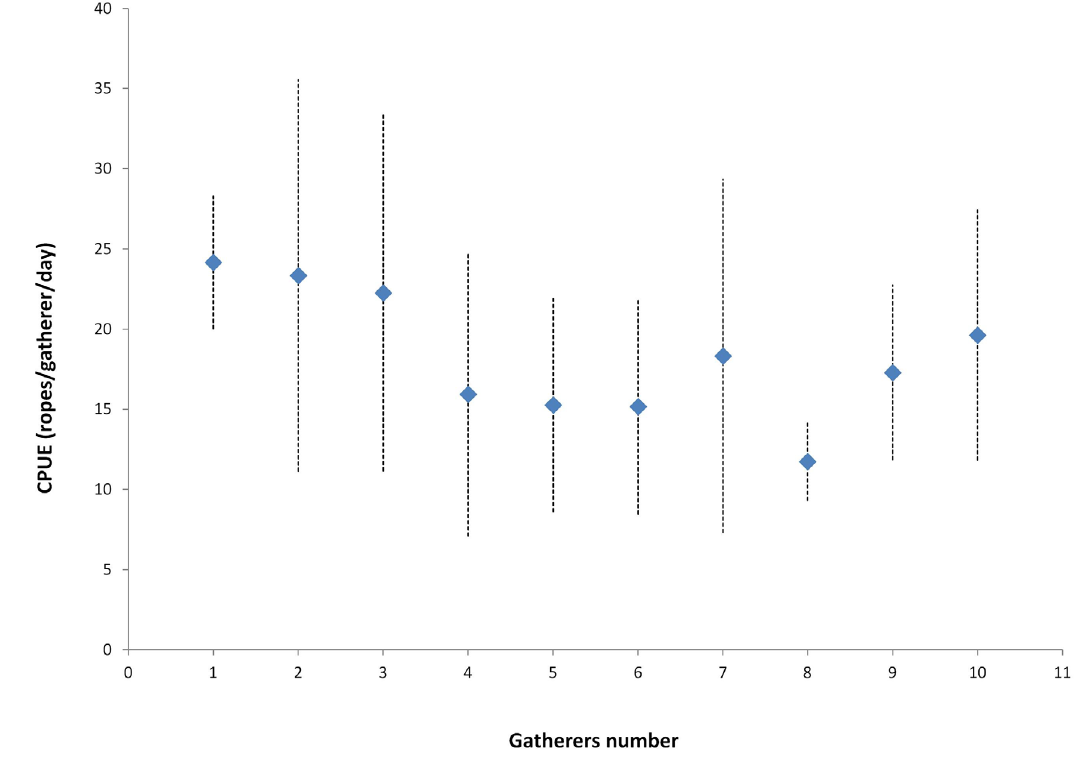
Figure 6. CPUE according to the number of Ucides cordatus gatherers in the Parnaíba Delta, Brazil. Dotted lines represent the standard